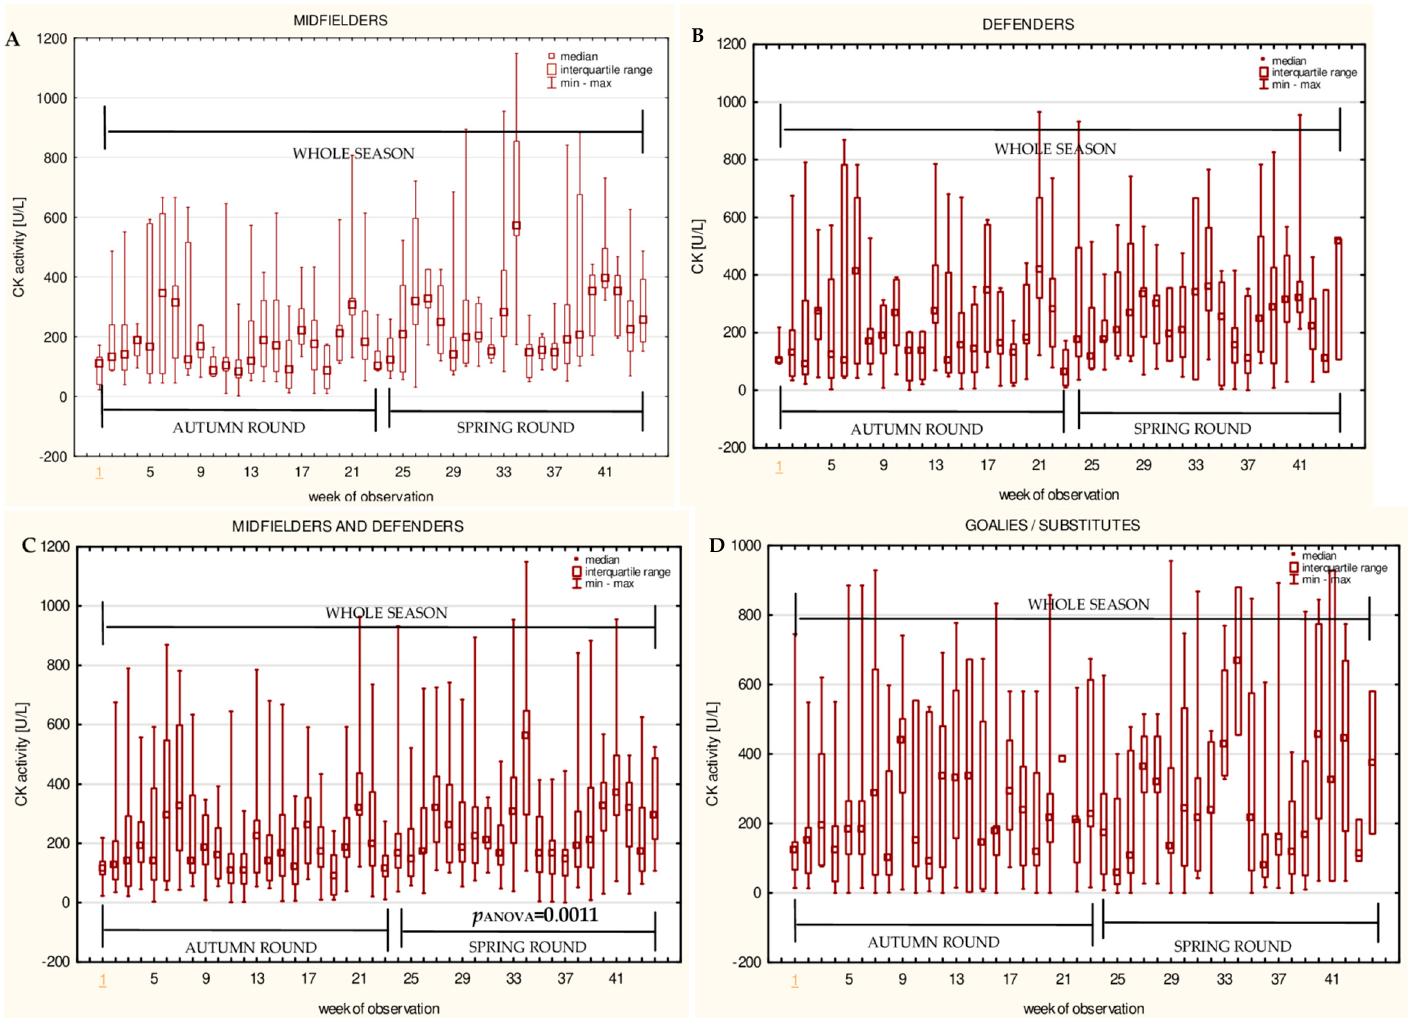
Figure 3. Median creatine kinase (CK) activities in: ( A ) The midfielder, ( B ) defender, ( C ) midfielder/defender and ( D ) goalie/substitute subgroups over the course of the soccer match season.